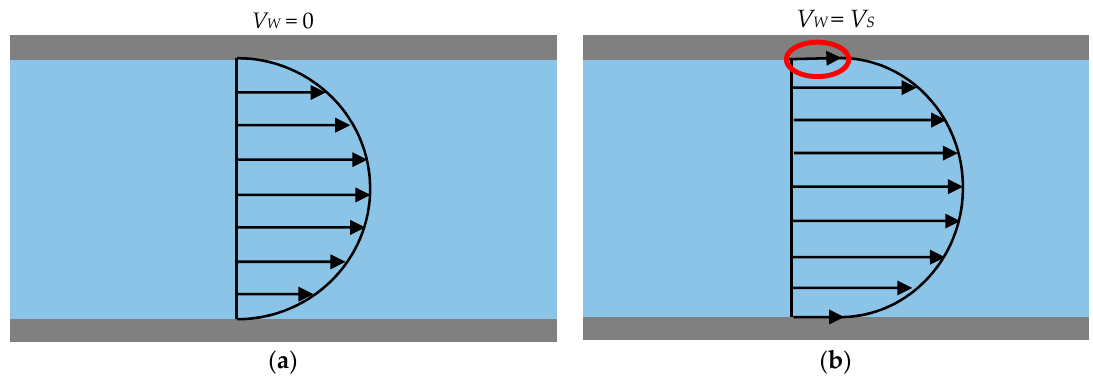
Figure 5. Velocity profiles of a suspension fluid at the wall: ( a ) no-slip; and ( b ) slip velocity ( V s ).